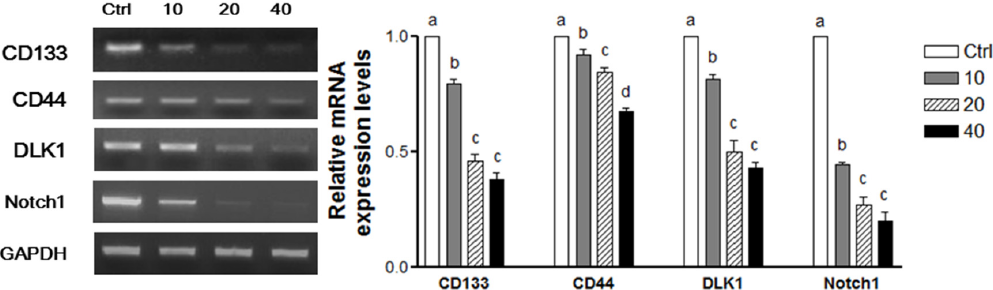
Figure 6. WPE down ‐ regulates CD133, CD44, DLK1, and Notch1 in human primary cells from colorectal cancer tissue. Primary cancer cells were treated with varying concentrations of WPE (0, 10, 20, and 40 μ g/mL) for 3 d. mRNA expressions of CD133, CD44, DLK1 and Notch1 were detected by RT ‐ PCR, and GAPDH was used as a loading control. The values shown are the means ± SEM. A p ‐ value < 0.05 was considered significant. Ctrl, Control.